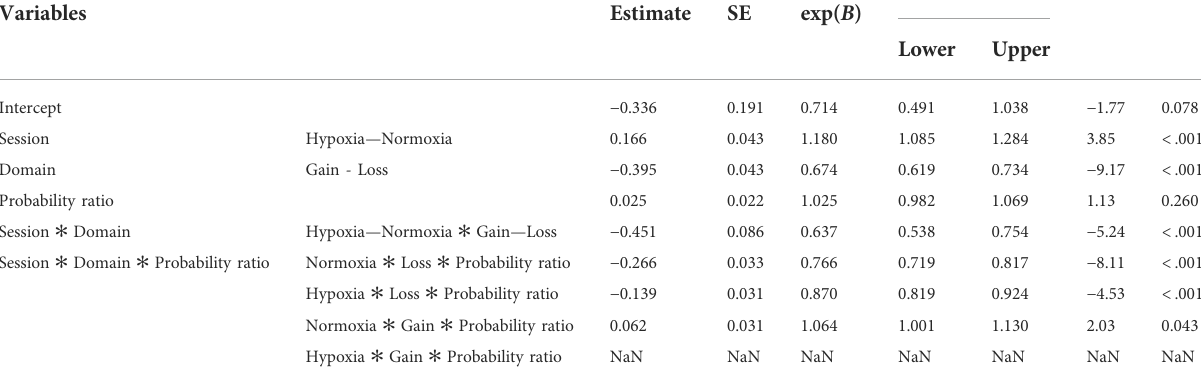
TABLE 1 Main results of GLMM analysis performed on participants ’ responses in the decision-making task.